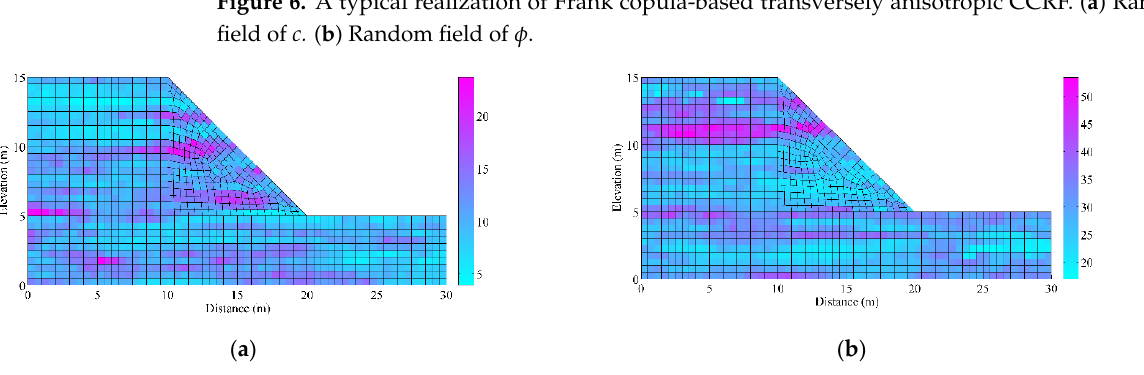
Figure 7. A typical realization of No. 16 copula-based transversely anisotropic CCRF. ( a ) Random field of c . ( b ) Random field of ϕ.